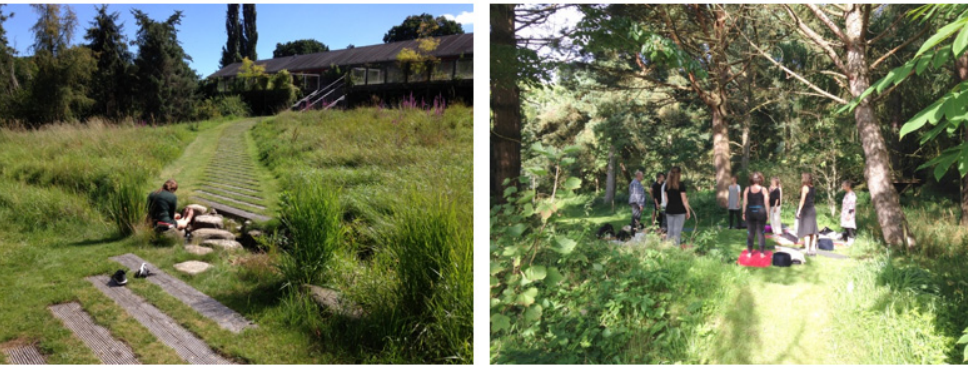
Figure 2. The participants in The Therapy Garden Nacadia ® Photos: Trine Fryjana Theede.